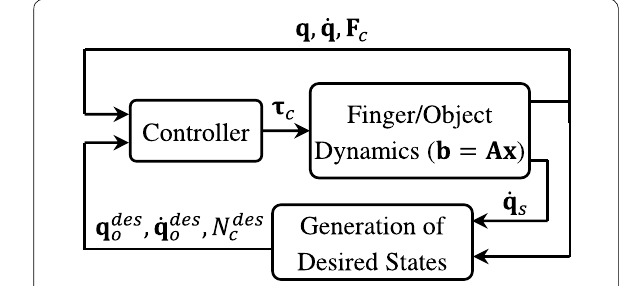
Fig. 8 Block diagram of closed-loop